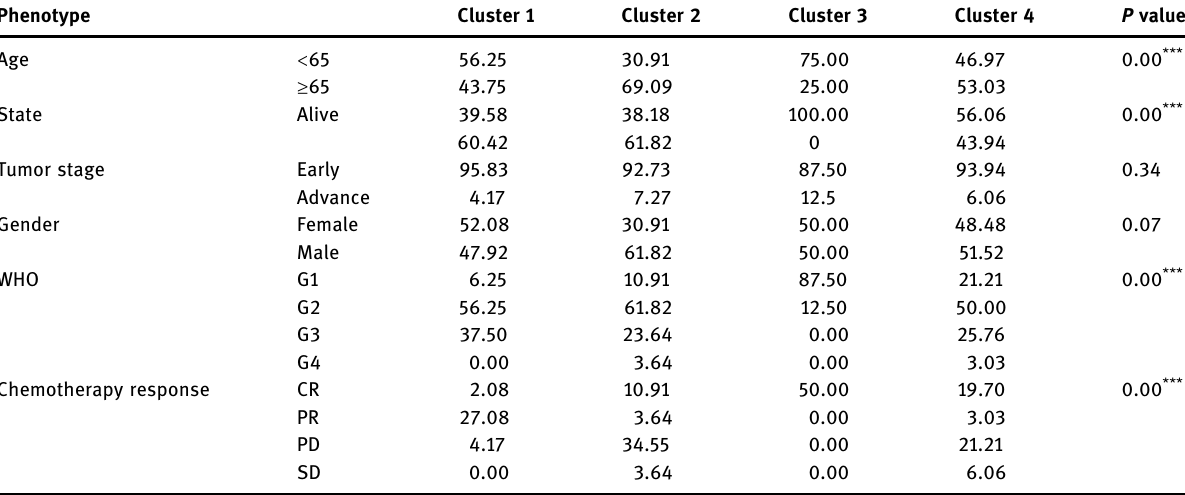
Table 1: Comparison of clinical characteristics distribution di ff erences among di ff erent subgroups of TCGA Phenotype